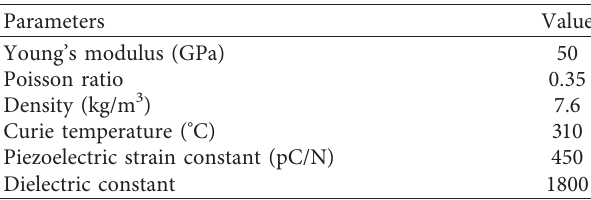
Figure 2: SA. Table 1: Parameters of the selected PZT patch.